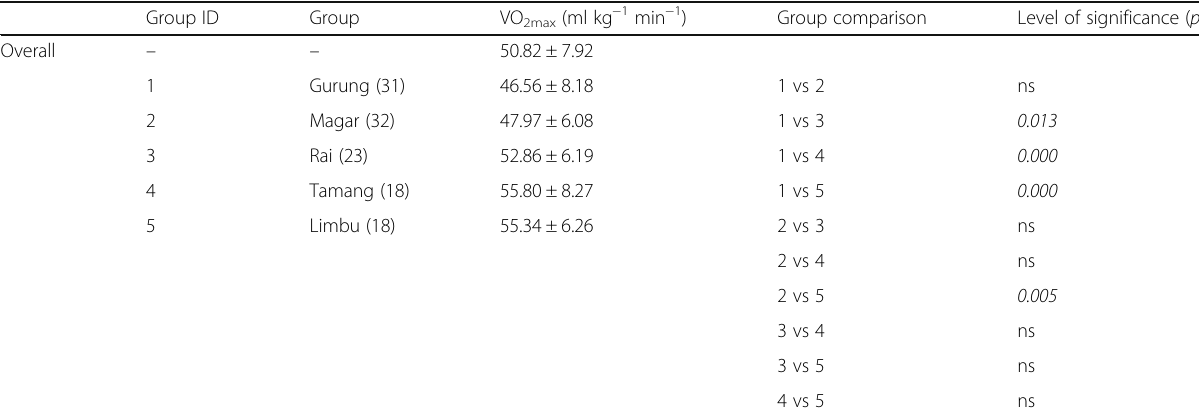
Table 4 Comparison of VO 2max between Gorkha groups Group ID Group